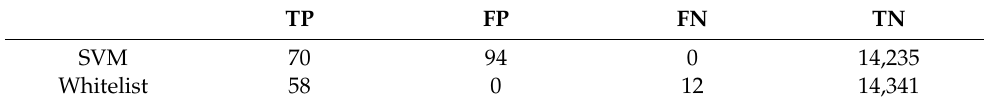
Table 6. Results from SVM and the PLC-based whitelist system of MV201 in dataset 1. TP